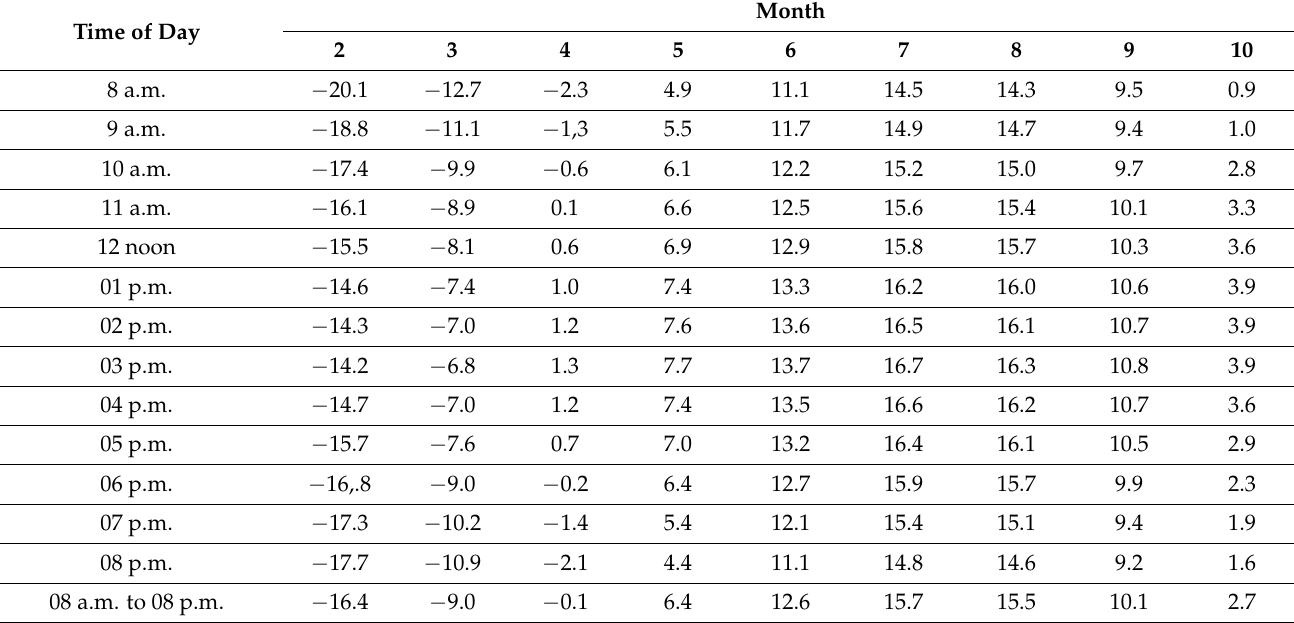
Table 4. Average monthly air temperature ( ◦ C) for each hour of day-time and average monthly